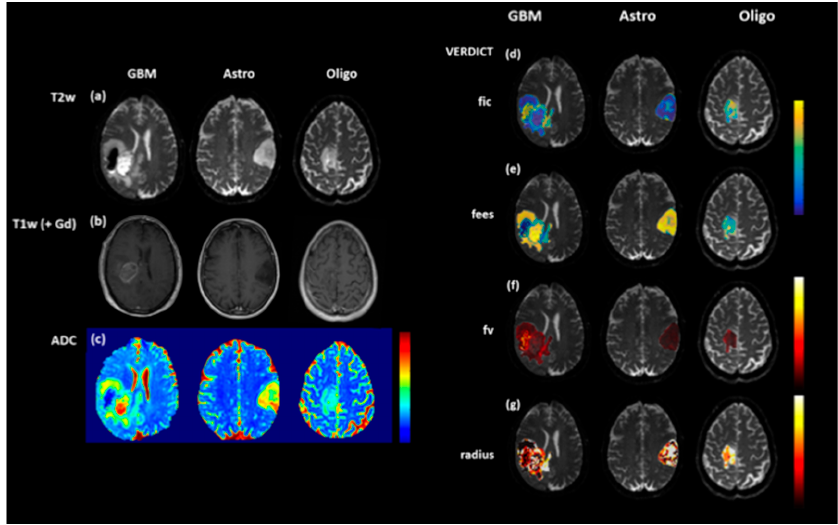
Figure 2. T2-weighted (T2W ( a ), T1-weighted (T1W) post contrast ( b ) and ADC maps ( c ) in a range of brain tumours: glioblastoma multiforme (GBM), diffuse astrocytoma (Astro) and oligodendroglioma (Oligo). Although the ADC map for the oligodendroglioma ( c ) is relatively uniform, the Vascular, Extracellular, and Restricted Diffusion for Cytometry in Tumours (VERDICT) parameter map fic (intracellular fraction) ( d ) demonstrates increased signal at the anterior margin, thought to be a marker of increased cell density. The other VERDICT parameter maps ( e ) fees (extracellular, extravascular fraction), ( f ), fv (vascular fraction) and ( g ) radius (cell radius) also demonstrate tumour heterogeneity which could potentially be used to guide biopsy.